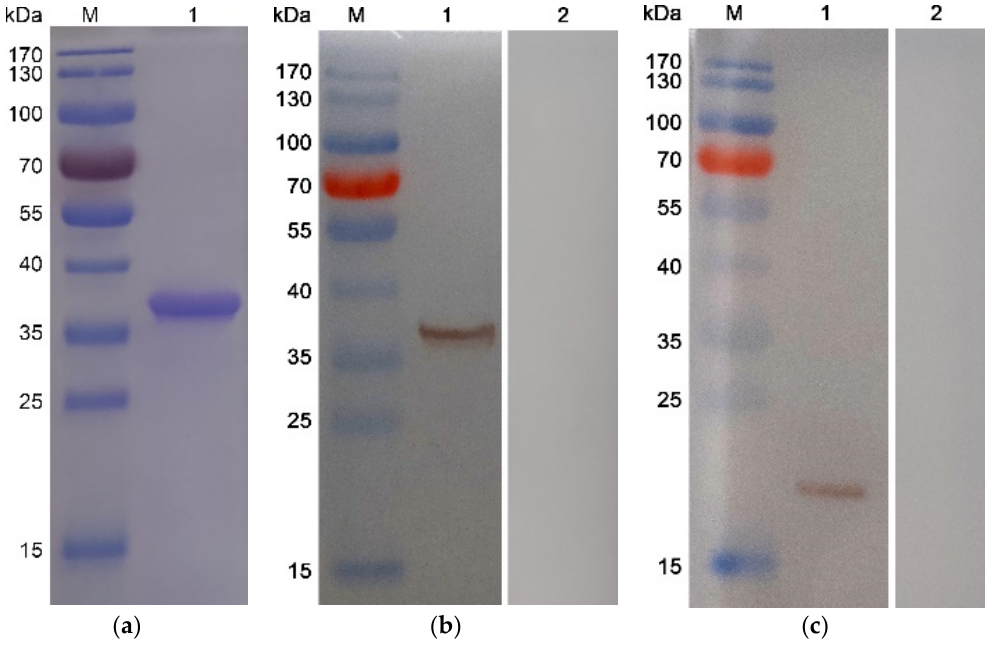
Figure 1. ( a ) SDS-PAGE analysis of the purification of recombinant TgH2A1. Line M: protein molecular weight marker; Line 1: rTgH2A1 purified by Ni 2 + charged column chromatography and dialysis. ( b ) Western blotting of recombinant TgH2A1. Line M: protein molecular weight marker; Line